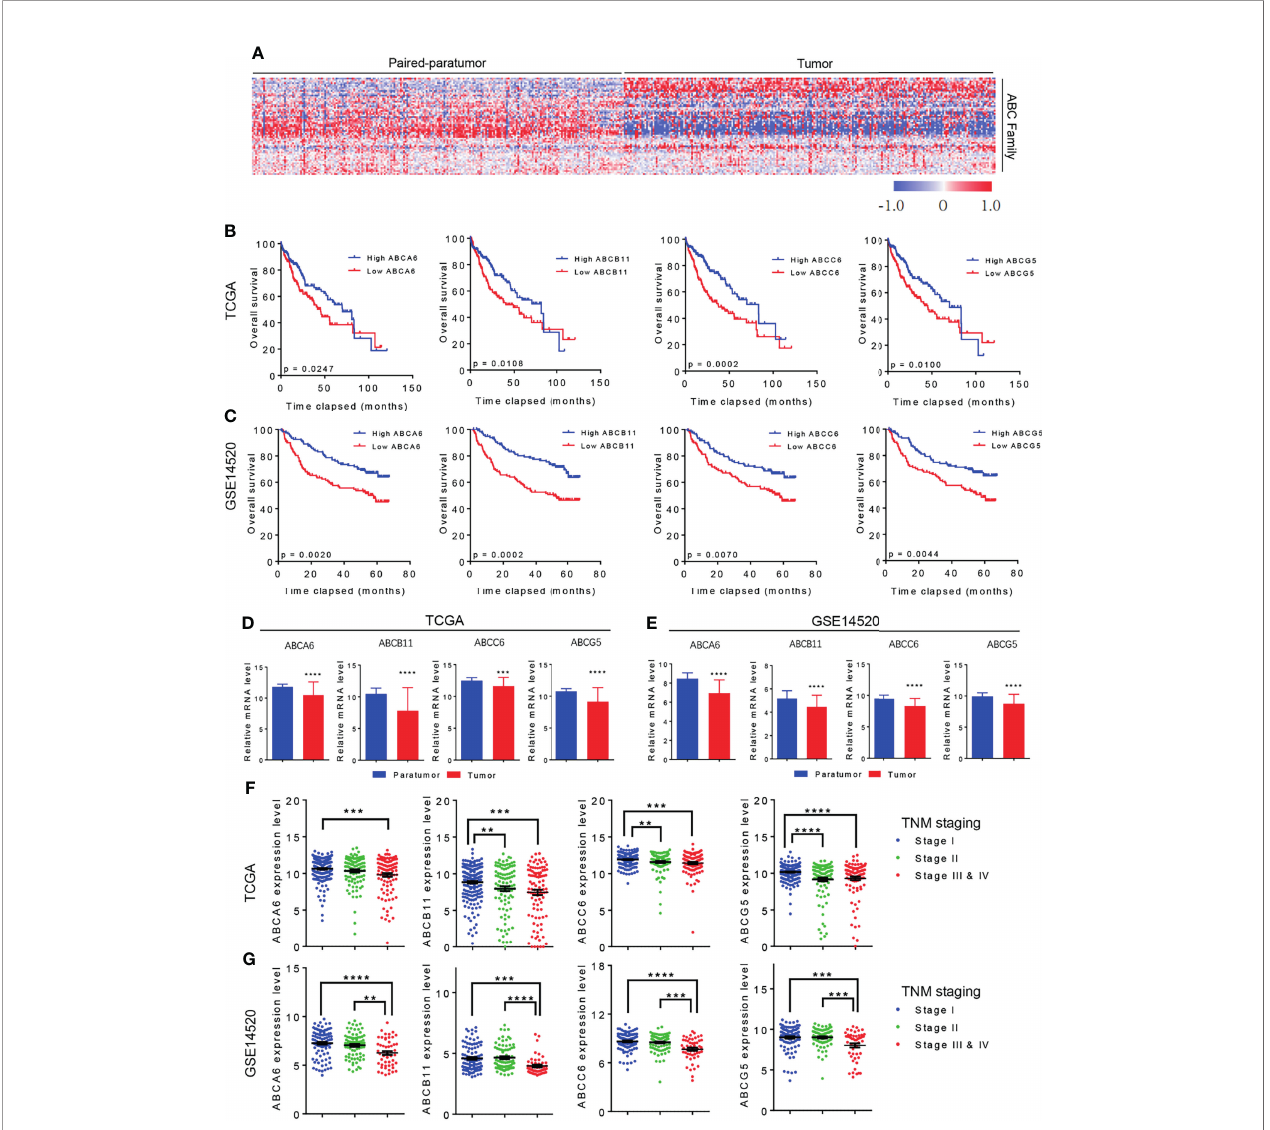
FIGURE 1 | The Role of ABC transporter family genes in HCC. (A) Heat map showing the differential expression of ABC transporter family genes in TCGA dataset. (B) Kaplan-Meier analysis showing the overall survival of patients with HCC in correlation with high or low ABC family genes level. Data was derived from TCGA dataset. (C) Kaplan-Meier analysis showing the overall survival of HCC patients in correlation with high or low ABC family genes level. Data was derived from GSE14520 dataset. (D) TCGA dataset showing the differential expression of ABC family genes in HCC paratumor tissues and tumor tissues. (E) GSE14520 dataset showing the differential expression of ABC family genes in HCC paratumor tissues and tumor tissues. (F) TCGA database showing the expression level of ABC family genes with advanced HCC TNM staging. (G) GSE14520 dataset showing the expression level of ABC family genes with advanced HCC TNM staging. Error bars indicate means ± SEM. P -values were determined by two tailed t -test (D, E) , one-way ANOVA (F, G) and Kaplan-Meier analysis (B, C) . ** P < 0.01, *** P < 0.001, **** P <